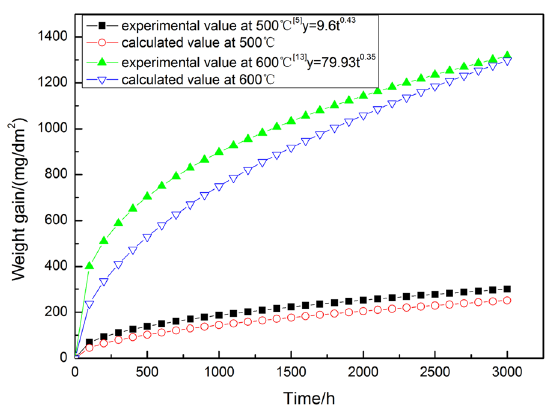
Figure 4: Relative errors between the simulated values and the experimental values of HCM12A oxidation weight gain in super - critical water at 500 and